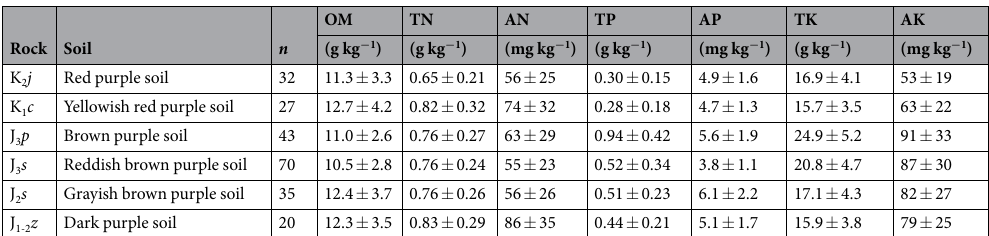
Table 8. Organic matter and nutrient contents of the purple soils. Note: OM, organic matter; TN, total nitrogen; AN, available nitrogen; TP, total phosphorus; AP, available phosphorus; TK, total potassium; AK, available